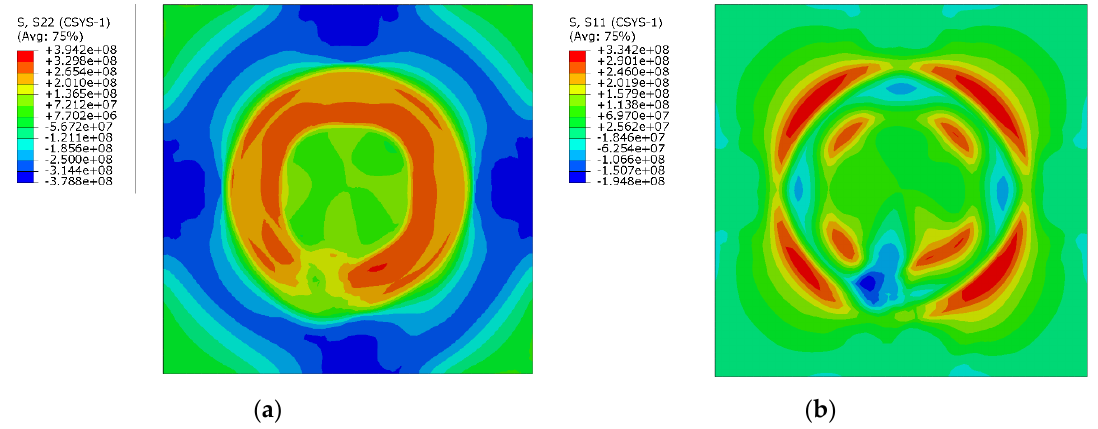
Figure 8. Full field residual stress distribution on upper model surface: ( a ) Circumferential stress; ( b ) radial stress.